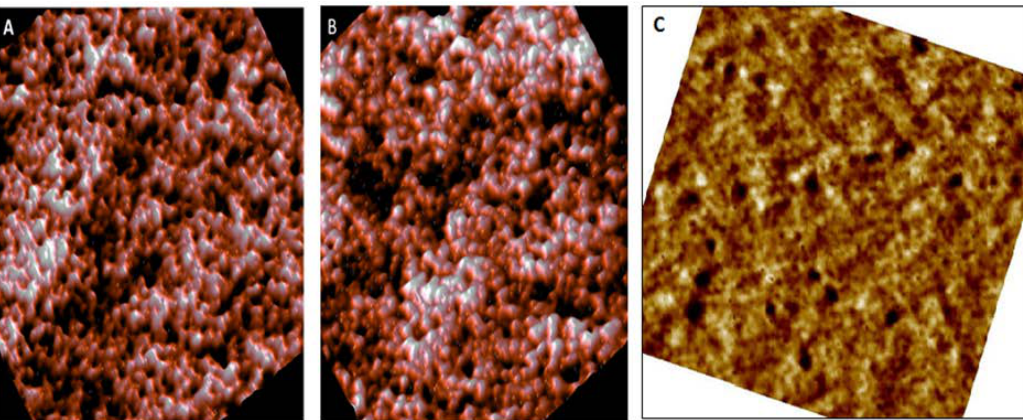
Figure 2. High-resolution images (Scan size is 900 × 900 nm) of the erythrocyte cell membrane taken by AFM for a healthy erythrocyte ( A ) and pre-diabetic erythrocyte ( B ). After filtering the images, the spectrin and actin network can be seen through the cell membrane. Mild pits and blowholes on the RBC (red blood cell) surface of diabetics ( C ). However, in the case of the diabetics, the surface is found with occasional blowholes and fissures, and the roughness is enhanced by about 15% (1.18 ± 0.60), as shown in Figure 2 and Table 1. Table 1. Statistical analysis of some erythrocyte parameters of the pre-diabetic, diabetic, and healthy individuals with significance p < 0.05.